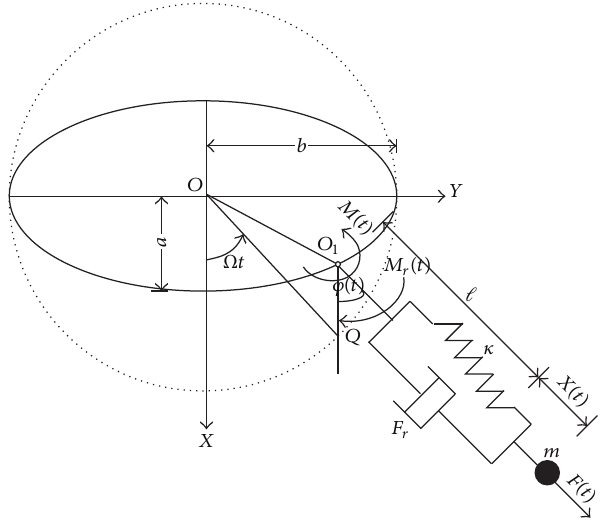
Figure 1: Description of the